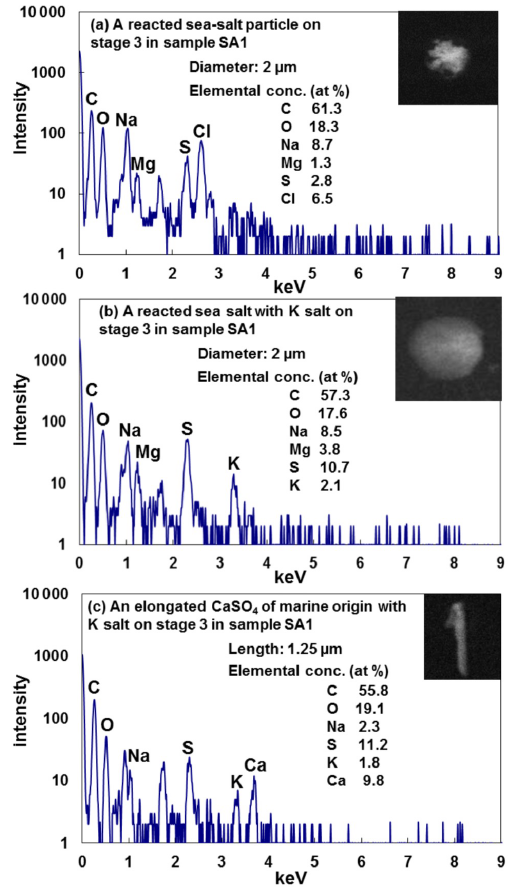
Figure 10. SEIs, X-ray spectra, and element atomic concentrations of (a) reacted sea salt, (b) reacted sea salt with K salt, and (c) elon- gated CaSO 4